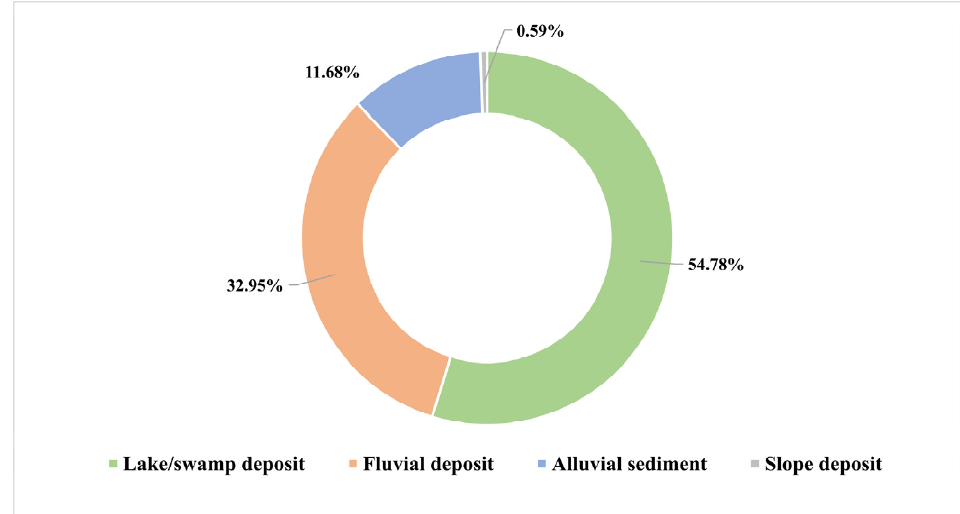
Figure 8. Liquefaction distribution in different Quaternary sediments.